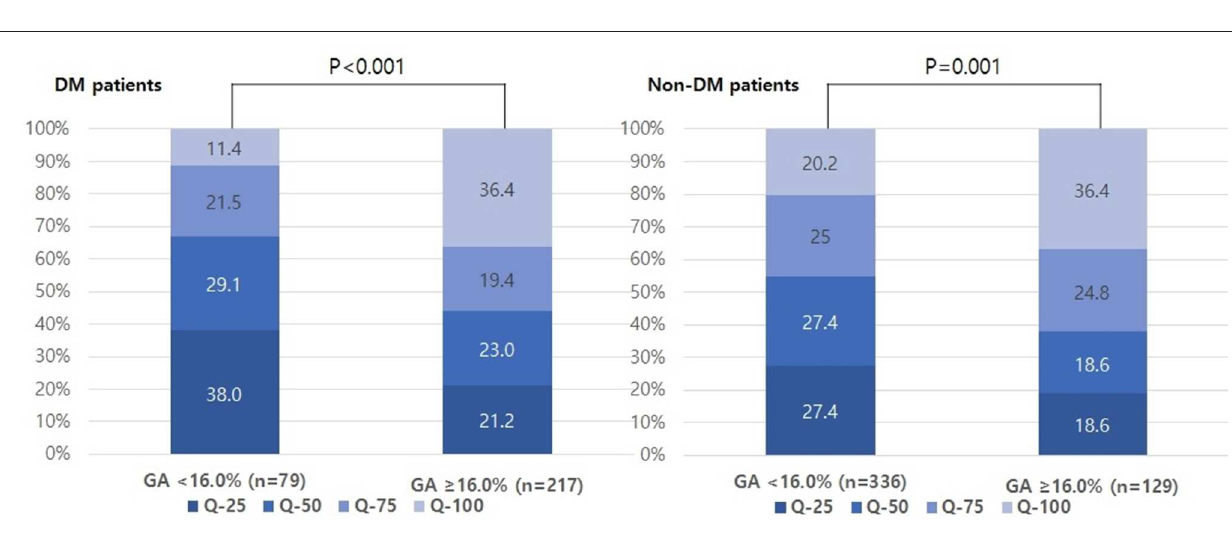
FIGURE 2 | Distributions of quartiles of infarct volumes according to GA levels in both DM and non-DM patients. GA, glycated albumin; DM, diabetic